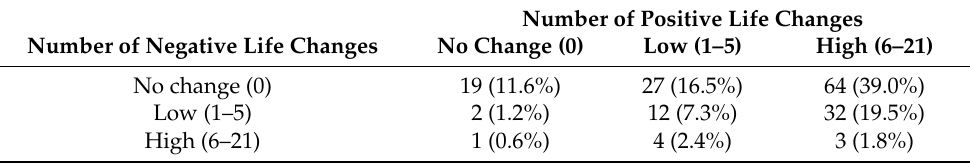
Table 4. Co-occurrence of positive and negative life changes ( N =